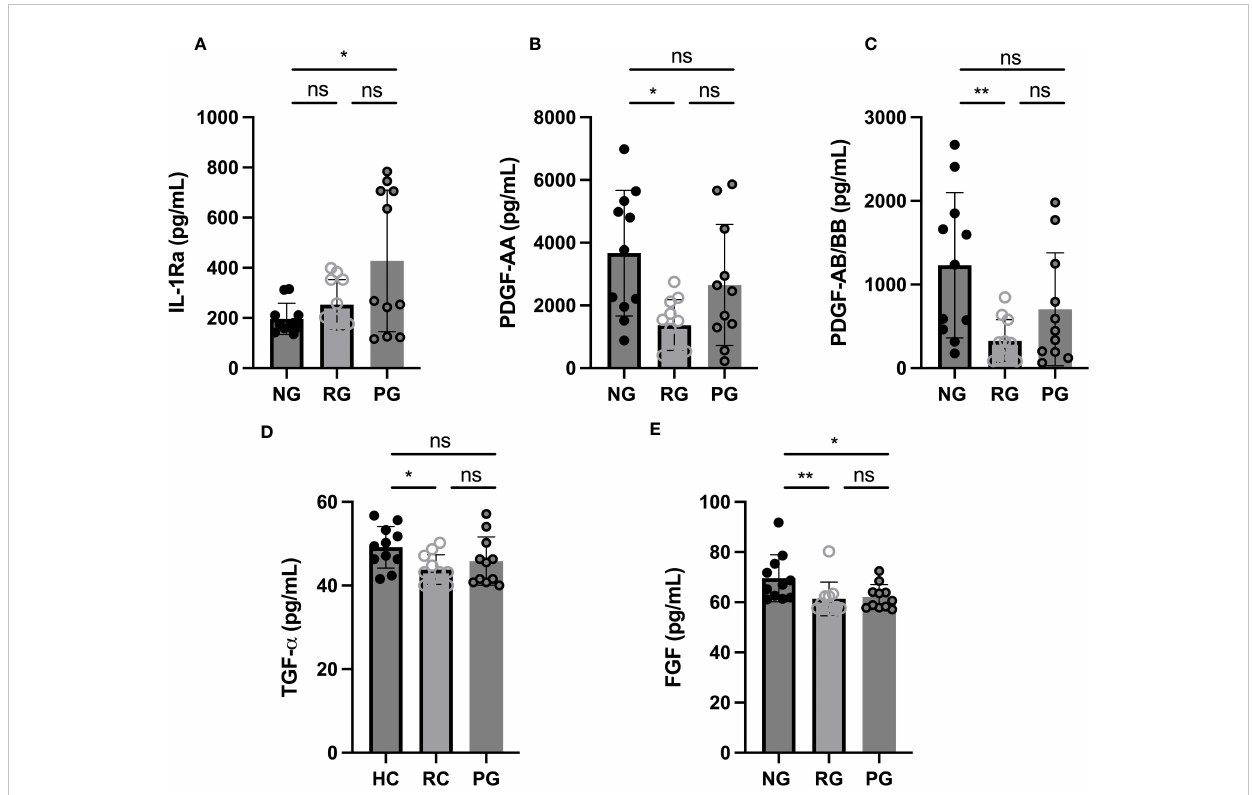
FIGURE 1 Plasma cytokine levels among groups. (A) IL-1Ra, (B) PDGF-AA, (C) PDGF-AB/BB, (D) TGF- a , and (E) FGF levels were measured in plasma collected from NG, RG, and PG. The data are represented as the box and scatter plots with each circle representing a single individual. P values were calculated using the Mann – Whitney U-test. *p < 0.05, **p < 0.01, ns, non-signi fi